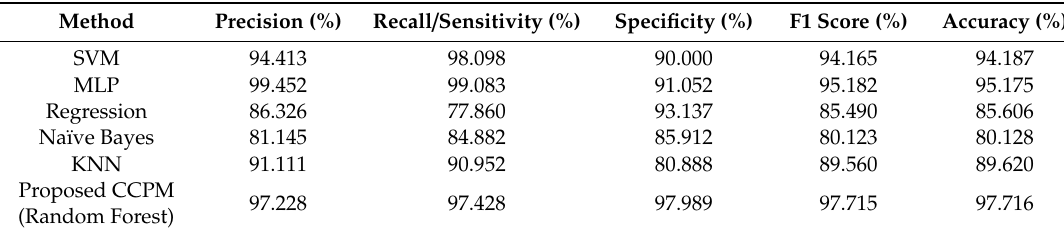
Table 19. Performance evaluation results based on DBSCAN and SMOTETomek for Cytology.